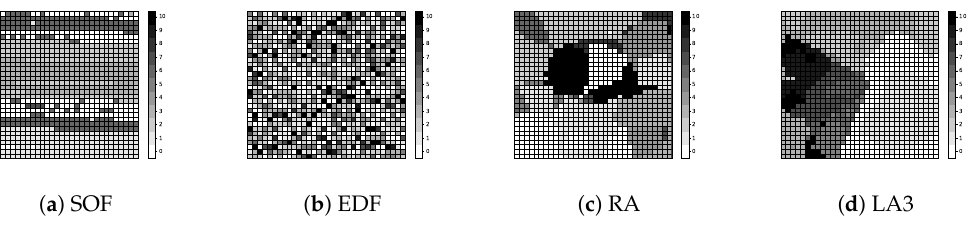
Figure 14. Object staleness snapshot examples by the models in Table